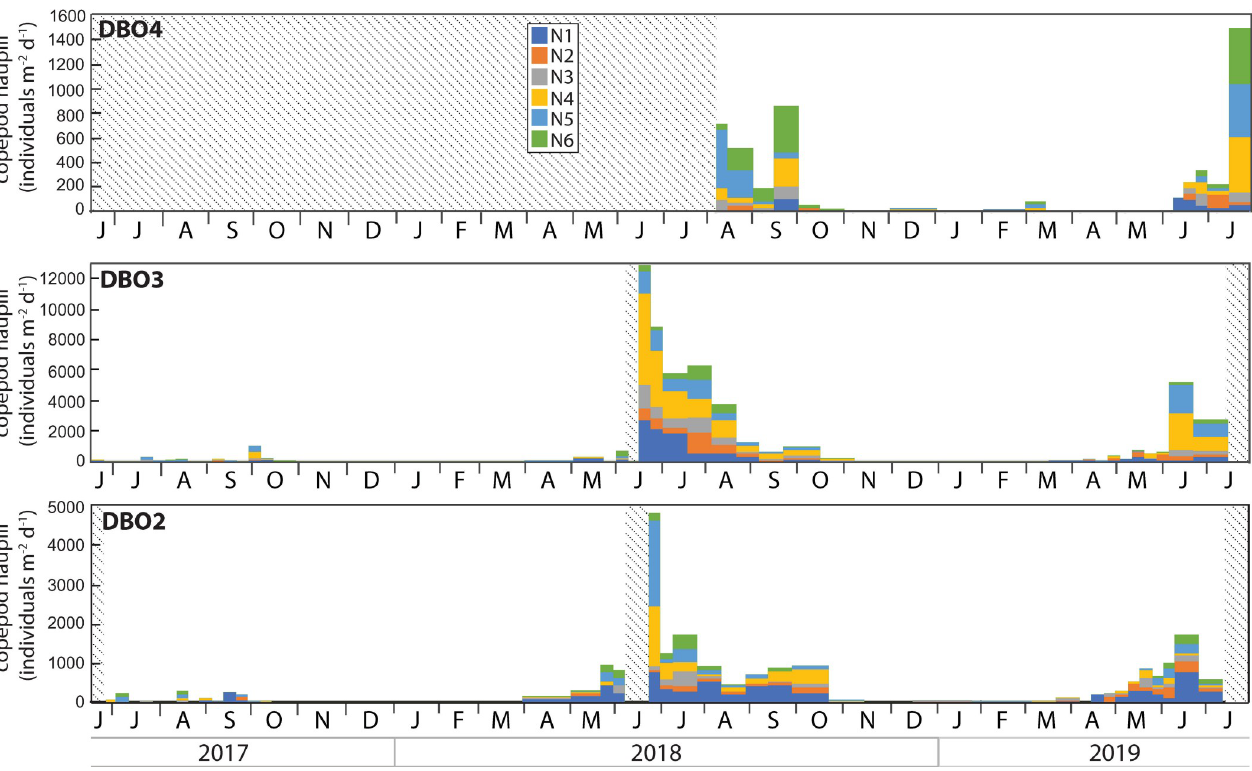
Fig 7. Nauplii of the copepod genus Calanus , Metridia and Pseudocalanus collected in the sediment trap at each mooring site. Note the different scales. Shaded areas represent periods without data.